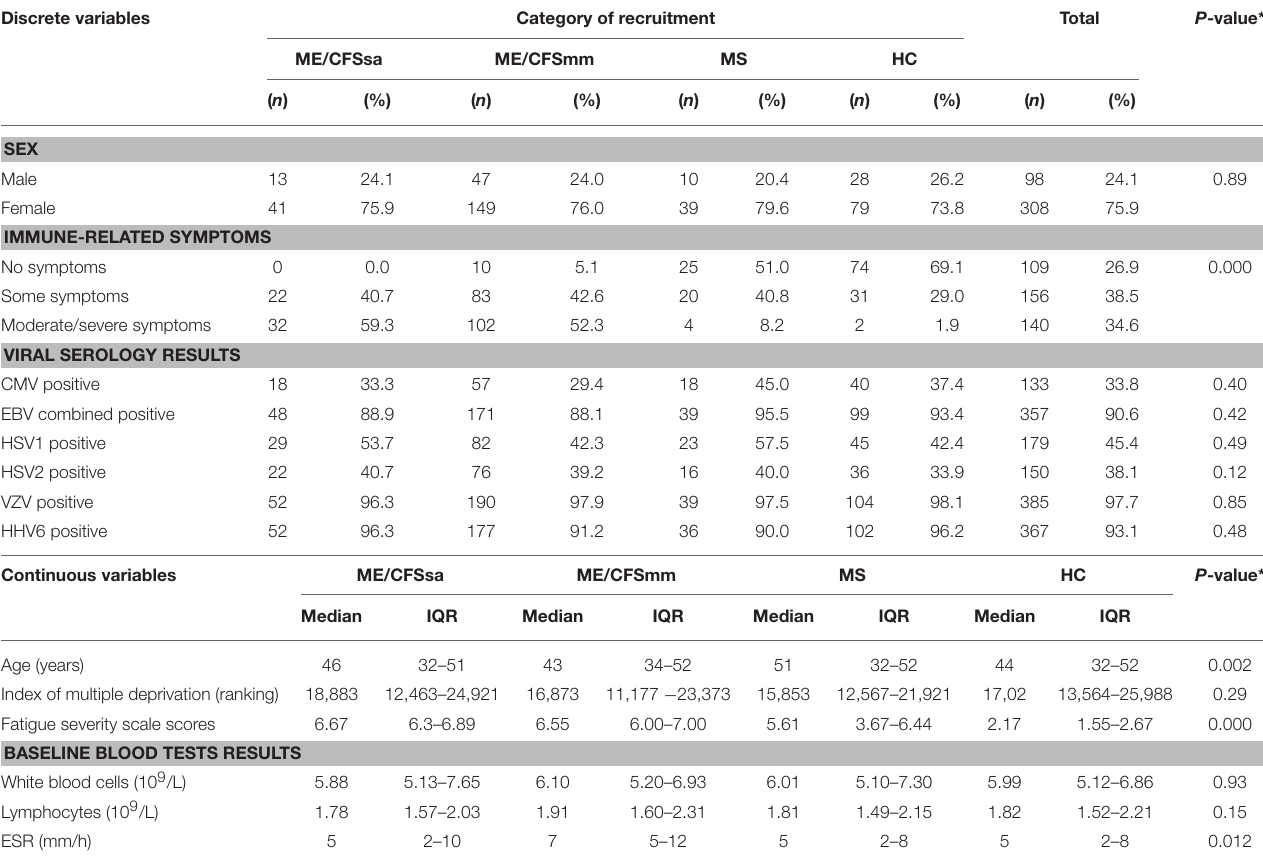
TABLE 1 | Description of study population, in relation to the following variables–demographic, socio-economic, immune-related symptoms, Fatigue Severity Scores, viral serology, and baseline routine blood tests results. Discrete